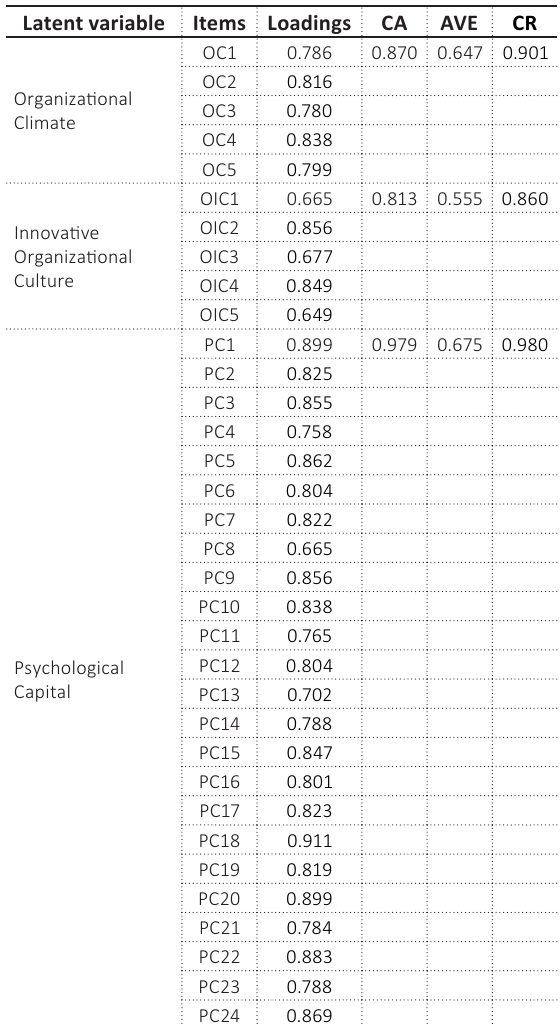
Table 2. Measurement model